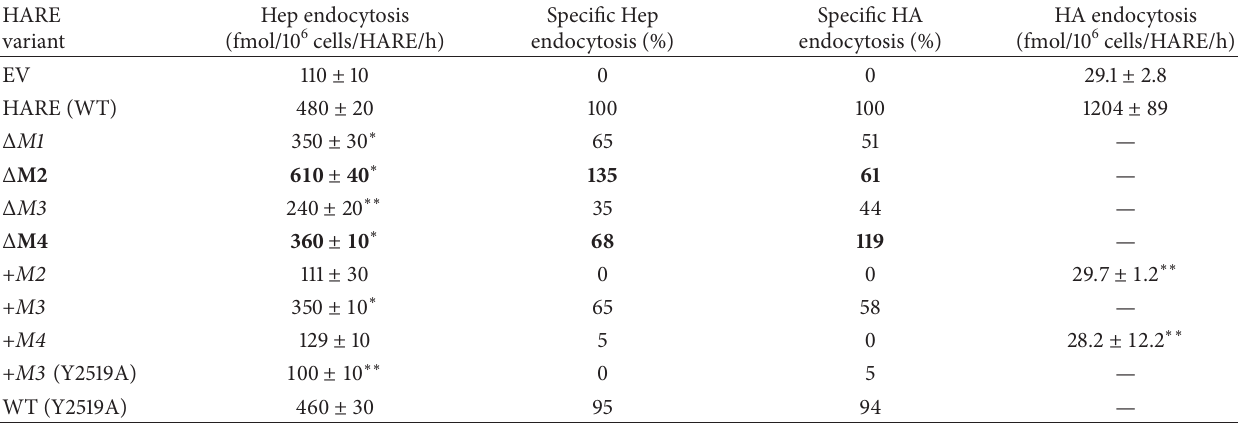
Table 1: Endocytosis of Hep or HA by WT or HARE CD